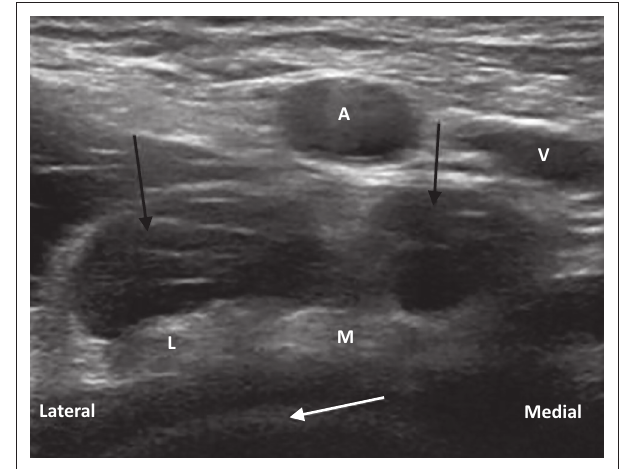
FIGURE 4: At the same level as in Figure 3 but with the leg in the neutral position, the medial tendon (M) has returned with a snap to lie medially against the acetabular rim in its normal position relative to the lateral tendon (L).